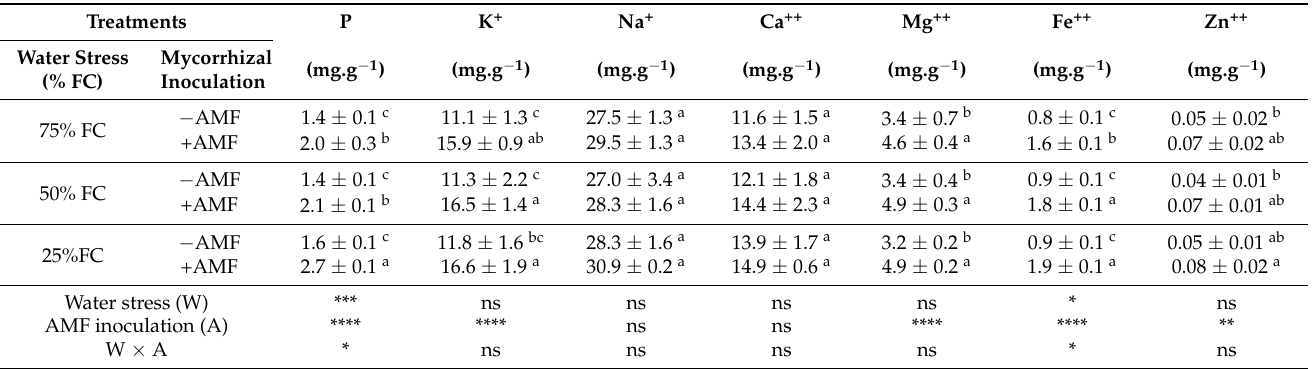
Table 3. Mineral macro- and micronutrients content of C. spinosa shoots cultivated without ( − AMF) or with (+AMF) AMF-complex at three advancing water-deficit levels (% FC).